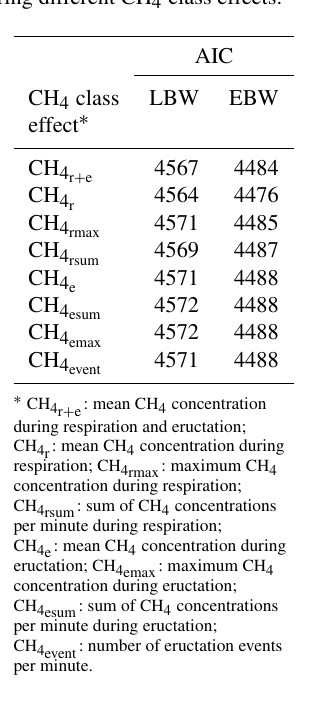
Table 2. Akaike information criterion (AIC) for model (1) with the dependent traits of lamb body weight (LBW) or ewe body weight (EBW), considering different CH 4 class effects.